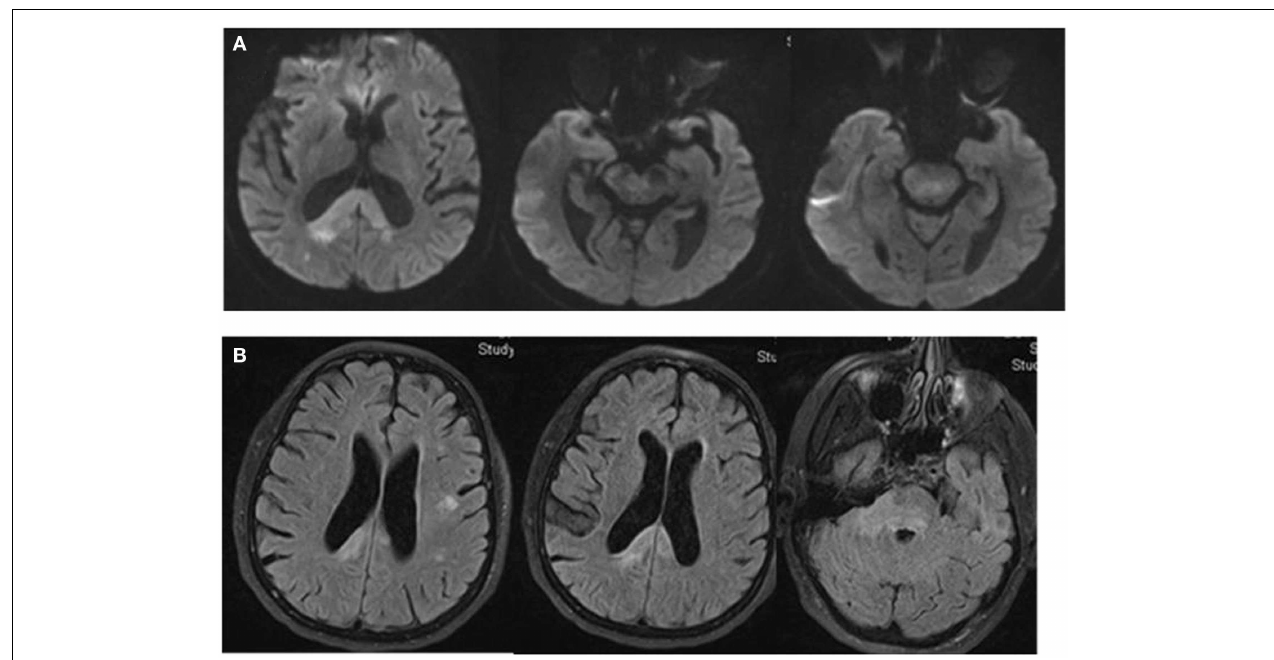
pons, and right cerebral peduncle (A). These areas are hyperintense on Fluid Attenuated Inversion Recovery (FLAIR) sequence.There is no evidence of mass effect (B) .